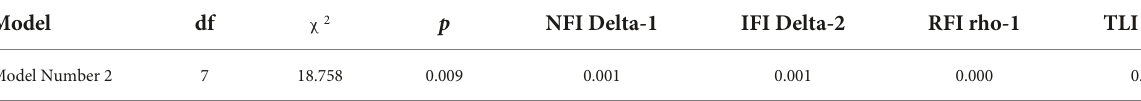
TABLE 5 Unlimited model (free estimates for all parameters).